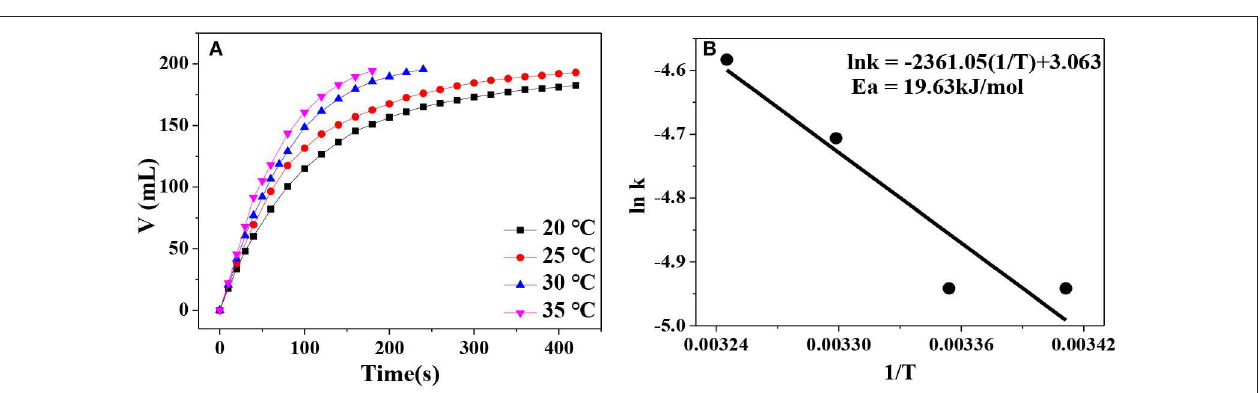
FIGURE 7 | (A) Hydrogen release from AB solution at different catalyst dosage; (B) the relationship between logarithm of mass of catalyst and catalytic rate.